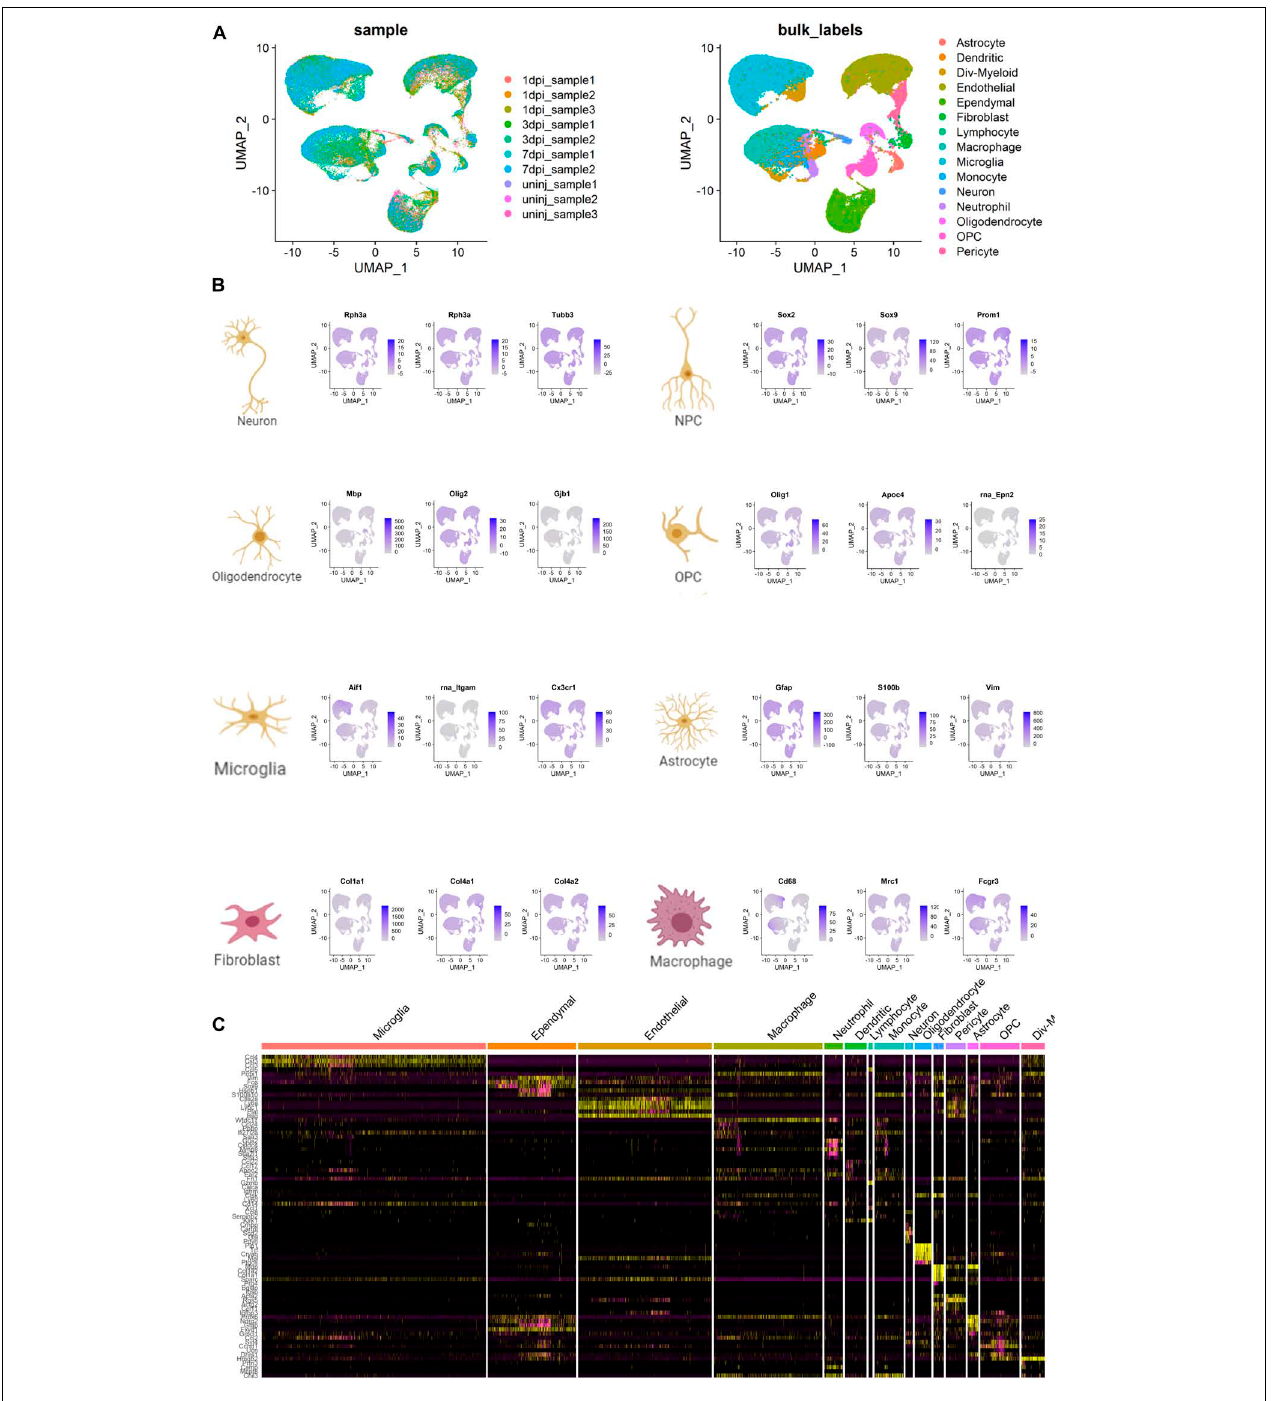
FIGURE 8 | Cell type annotation and cellular communication analysis. (A) Uniform Manifold Approximation and Projection (UMAP) scatter plots and cellular feature plots showing the cell types and marker genes for each cell type. (B) Cellular feature plots showing marker genes of different cell types. (C) Heat map showing the most significant differentially expressed genes (DEGs) of neuron and inflammation